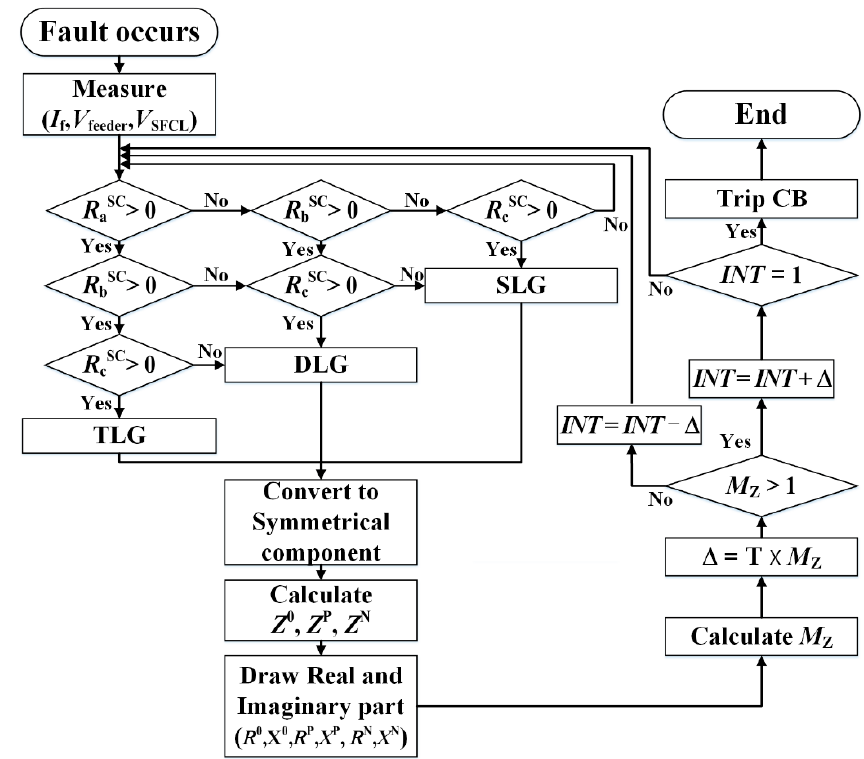
Figure 3. OCR operational algorithm flowchart.